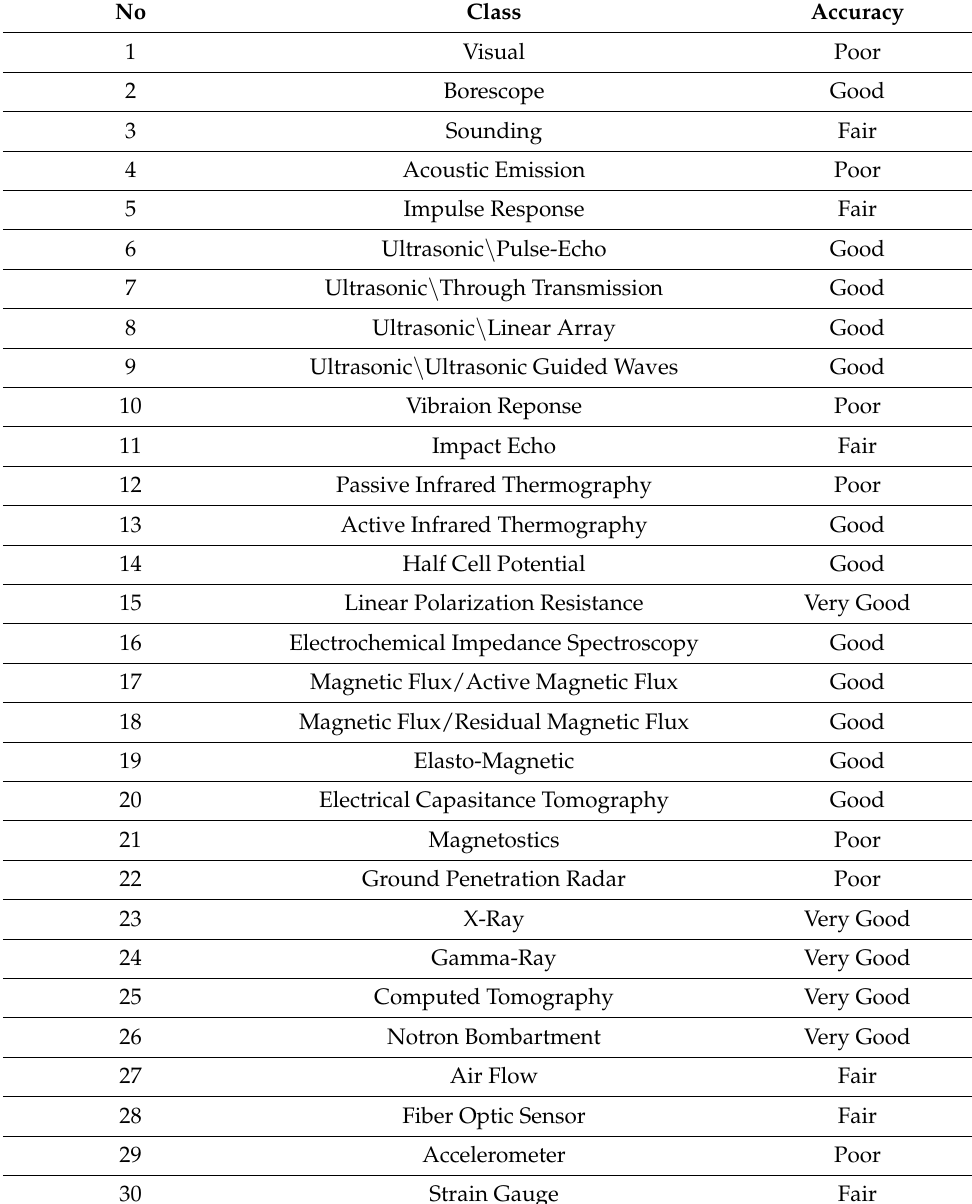
Table 2. Accuracy of NDE methods applicable to external post-tensioning system. No Class Accuracy 1 Visual